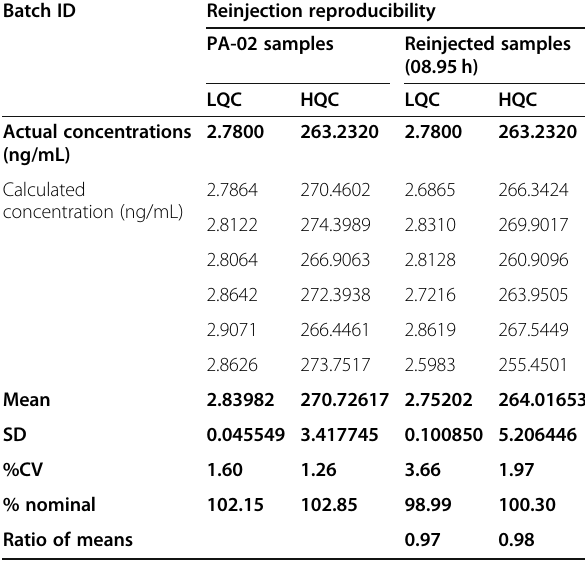
Table 19 Reinjection reproducibility for